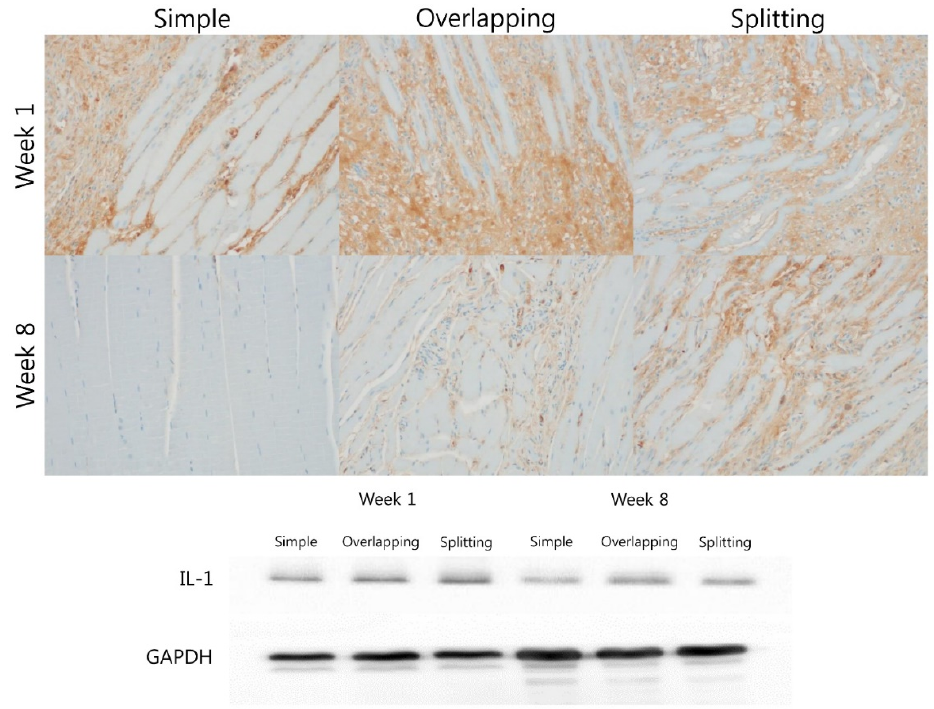
Figure 7. Immunohistochemical and Western blot analysis of IL-1 expression. At week 1, all groups showed strong expression of IL-1 by immunohistochemistry and Western blotting. The simple interrupted suture group exhibited weaker expression of IL-1 than the overlapping and splitting suture groups by immunohistochemistry and Western blotting.